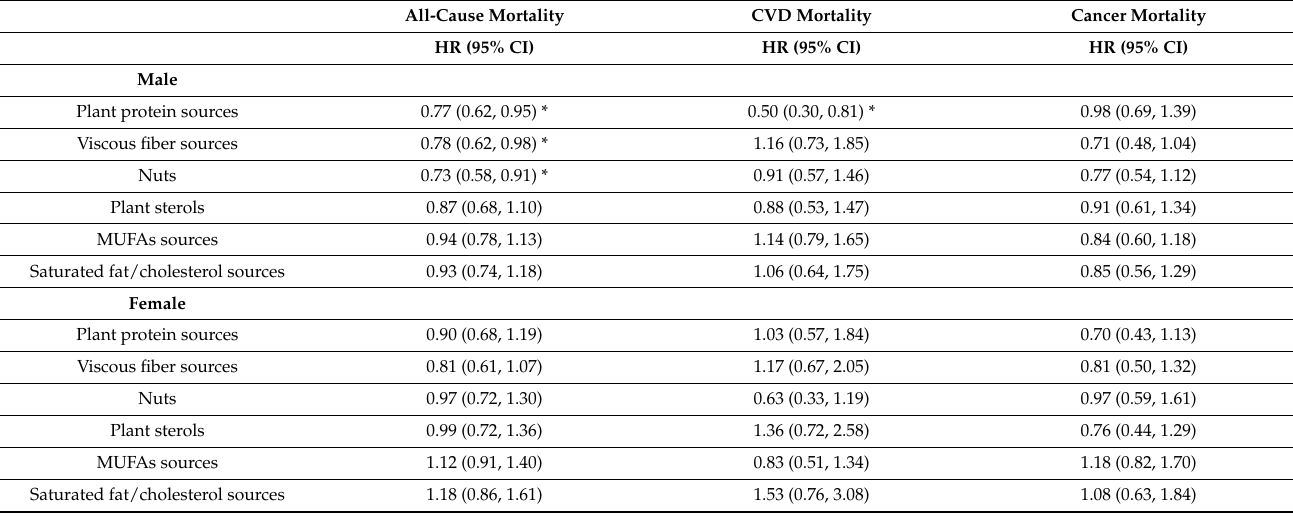
Table 4. Associations between the highest to lowest adherence to the individual components of the Portfolio Diet and risk of